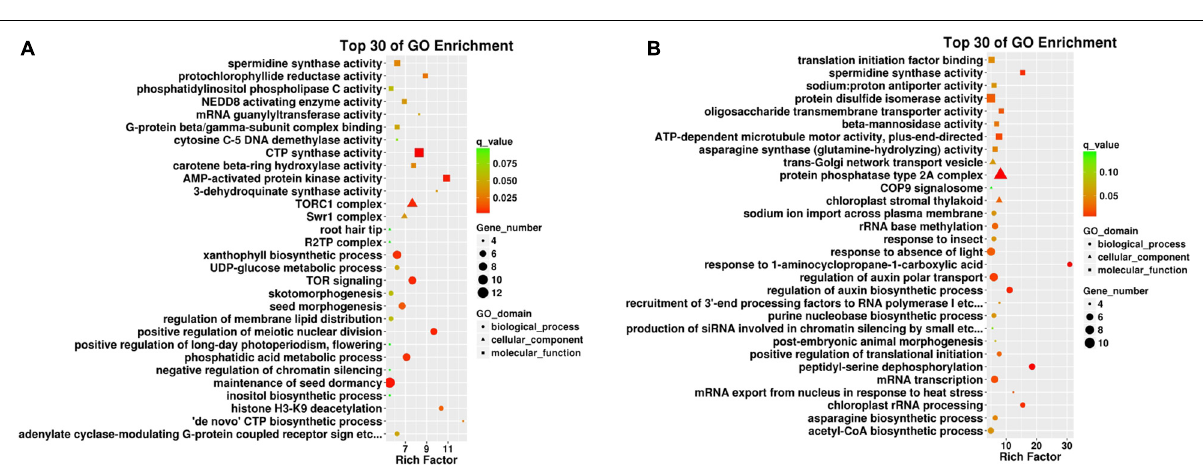
FIGURE 4 | Top 30 GO enrichment terms in different plant tissues such as (A) roots and (B) leaves. The x-axis indicates the rich factor of such GO terms in each tissue. The color of the point indicates the q-value of the GO terms, the size of the point indicates the number of genes enrich in such GO term, and the shape of the point indicates the domains of the GO